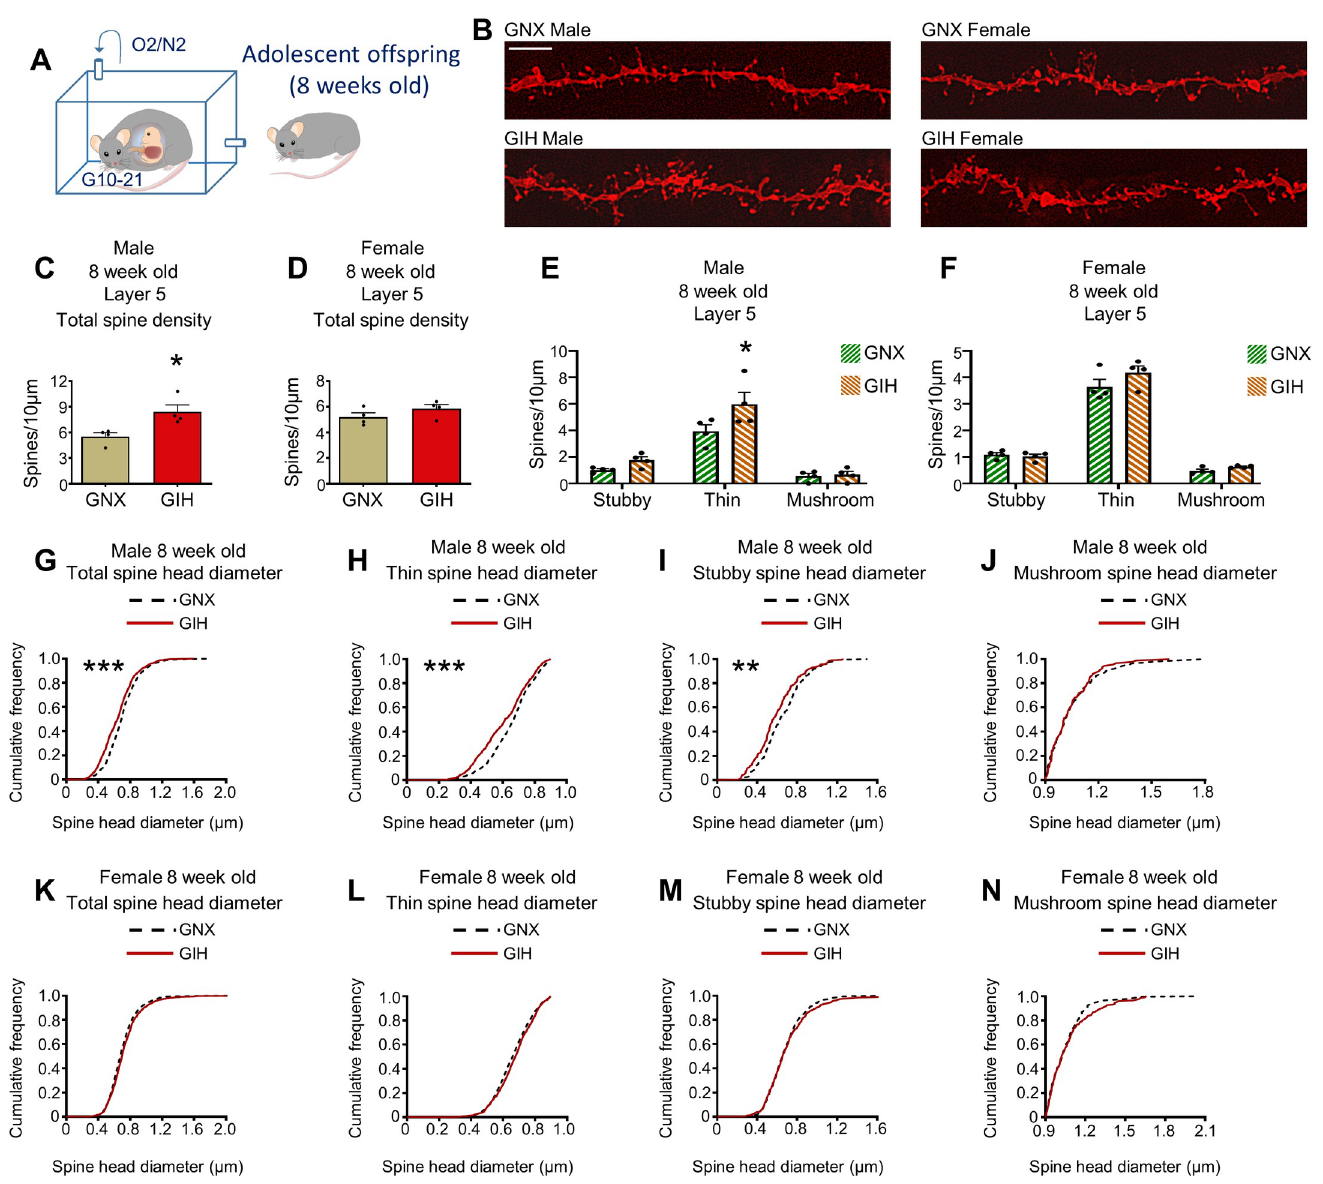
Fig 5. mPFC pyramidal neuronal dendritic spine density and morphology is altered in layer 5 in 8-week-old GIH offspring. (A) Schematic depicting GNX and GIH offspring age pertaining to all data in Fig 5. (B) Representative layer 5 pyramidal neuron dendrite segments from 8-week-old male and female GNX and GIH offspring. Scale bar = 10 μ m. (C) Assessment of total layer 5 dendritic spine density revealed a significant increase in male GIH offspring relative to male GNX offspring [t (df,6) = 3.109, p = 0.0209]. n = 4 GNX and 4 GIH rats. (D) Assessment of total layer 5 dendritic spine density reveals no significant differences between female GIH and GNX offspring [t (df,6) = 1.391, p = 0.2136]. n = 4 GNX and 4 GIH rats. (E) Spine subtype density analysis reveals a significant increase in thin spine density in male GIH offspring [Bonferroni post hoc (df,18) p = 0.0145] with no alteration in the density of stubby [Bonferroni post hoc (df,18) p = 0.7802] or mushroom spines [Bonferroni post hoc (df,18) p = 1.0]. n = 4 GNX and 4 GIH rats. (F) No differences in the density of any spine subtypes were identified between female GIH and GNX offspring [Bonferroni post hoc (df,18) stubby p = 1.0; thin p = 0.0987; mushroom p = 1.0]. n = 4 GNX and 4 GIH rats. (G) Analysis of cumulative total spine head diameter curves revealed a significant leftward shift in the curve for male GIH offspring (median survival differential 7.4%; χ 2 = 53.36, p < 0.0001). n = 1,702 GNX and 979 GIH spines. (H) Analysis of cumulative thin spine head diameter curves revealed a significant leftward shift in the curve for male GIH offspring (median survival differential 8.0%; χ 2 = 37.64, p < 0.0001). n = 1,180 GNX and 685 GIH spines. (I) Analysis of cumulative stubby spine head diameter curves revealed a significant leftward shift in the curve for male GIH offspring (median survival differential 10.52%; χ 2 = 9.605, p = 0.0019). n = 310 GNX and 204 GIH spines. (J) No significant differences in the cumulative mushroom spine head diameter curve were identified between male GIH and GNX offspring (median survival differential 0.78%). n = 212 GNX and 90 GIH spines. (K–N) No significant differences in total or spine subtype cumulative head diameter curves were identified between female GIH and GNX offspring (total spine median survival differential 3.23%, thin differential 2.6%, stubby differential 0.78%, and mushroom differential 0.4%). n = 2,376 GNX and 1,682 GIH total spines; 1,683 GNX and 1,155 GIH thin spines; 469 GNX and 323 GIH stubby spines; 224 GNX and 204 GIH mushroom spines. All bar graphs are the mean + SEM. The data underlying this figure can be found in S1 Raw Data. GIH, gestational intermittent hypoxia; GNX, gestational normoxia; mPFC, medial prefrontal